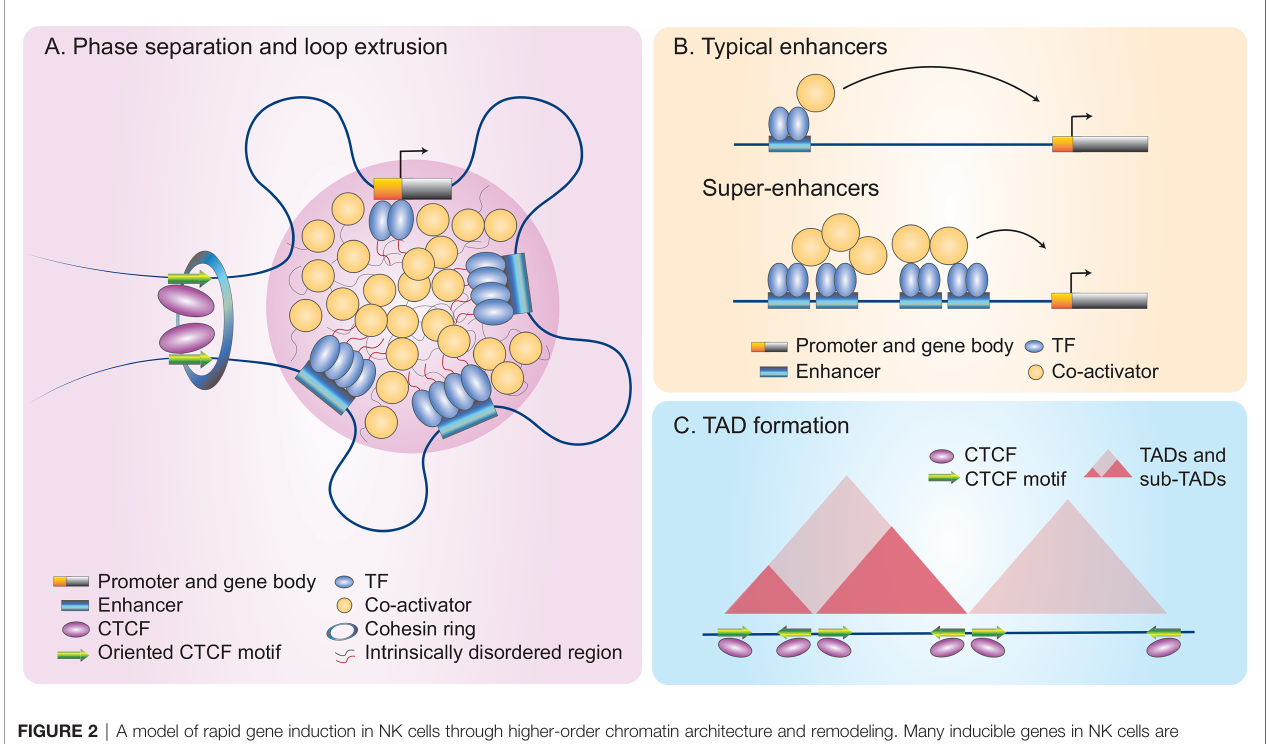
FIGURE 2 | A model of rapid gene induction in NK cells through higher-order chromatin architecture and remodeling. Many inducible genes in NK cells are associated with super-enhancers (SEs) that can be orderly modulated by multi-dimensional epigenetic mechanisms (72). (A) Phase separation. Phase separation occurs as a dynamic process in which transcription factors (TFs) and co-activators form non-membrane bound condensates through weak multivalent protein- protein interactions of their intrinsically disordered region (130). Multi-loop hubs bring TF-bound regulatory elements (REs) and their target genes into close proximity to fi netune gene expression. (B) Super-enhancers (SEs). SEs differ from typical enhancers as they recruit large numbers of TFs and transcriptional apparatus, including co-activators, to drive high magnitude of gene induction (130 – 132). (C) Topologically associating domains (TADs). Hi-C plots allow for visualization of three- dimensional TADs and sub-TADs, which form during the cohesin-mediated loop extrusion process. Looping can occur between two convergently oriented CCCTC- binding factor (CTCF) sites, using a cohesin ring that extrudes DNAs as shown in (A) (2, 133 –